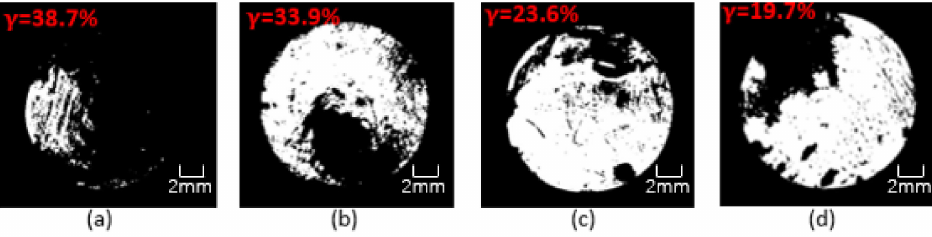
Figure 18. Binary image of each coating in seawater of 40% concentration for 60 days: ( a ) G1; ( b ) G2; ( c ) G3; ( d ) G4.